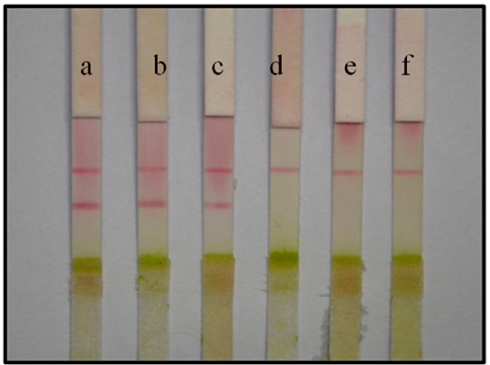
Figure 3. Specificity of the ICS test for detecting CGMMV. ( a ) CGMMV infection of watermelon tested positive. ( b ) CGMMV infection of zucchini tested positive. ( c ) CGMMV infection of tobacco tested positive. ( d ) TMV infection of tobacco tested negative. ( e ) CMV infection of tobacco tested negative. ( f ) A healthy leaf (control) gave a negative result.